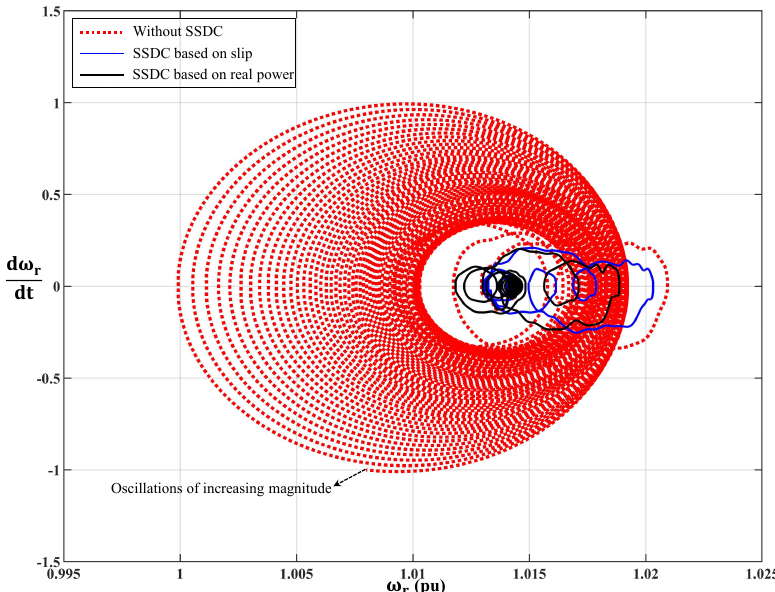
Figure 17. Phase plane trajectory of rotor speed in response to a grid voltage disturbance.